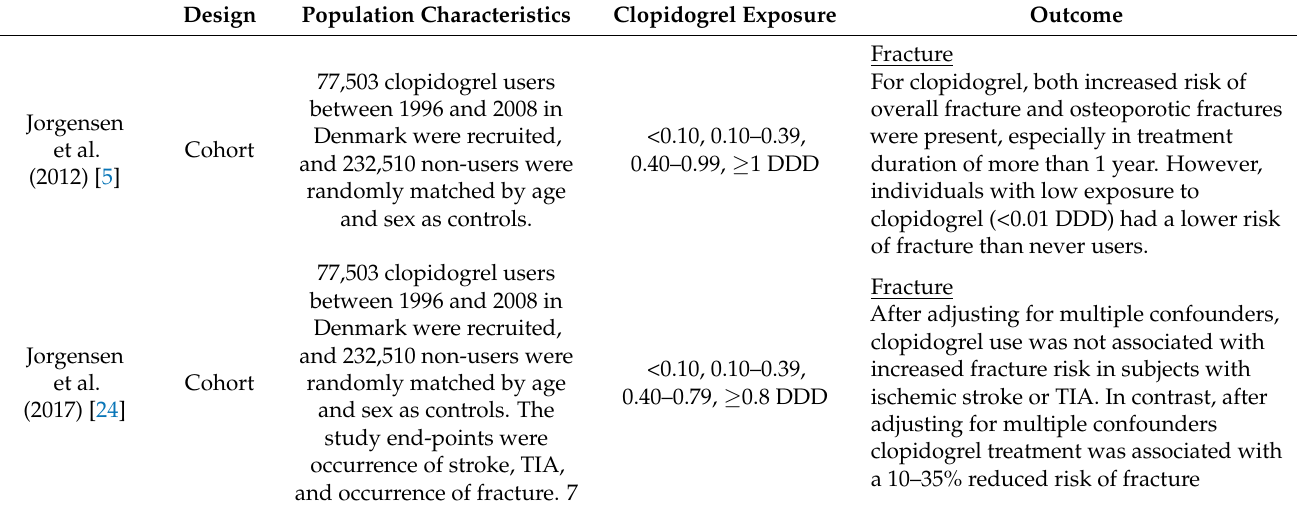
Table 7. Characteristics of publications discussing the correlation between clopidogrel and